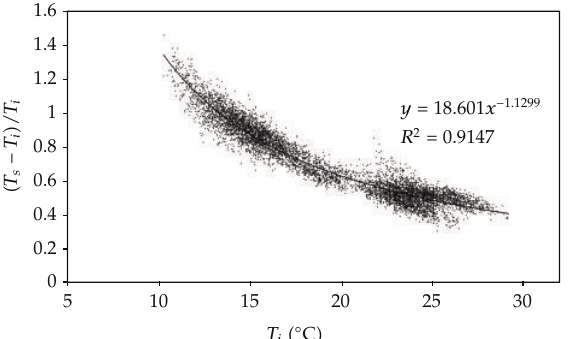
Figure 2: Input and output temperature fit equation for the units 5 and 6 working together from data between September 2003 and March